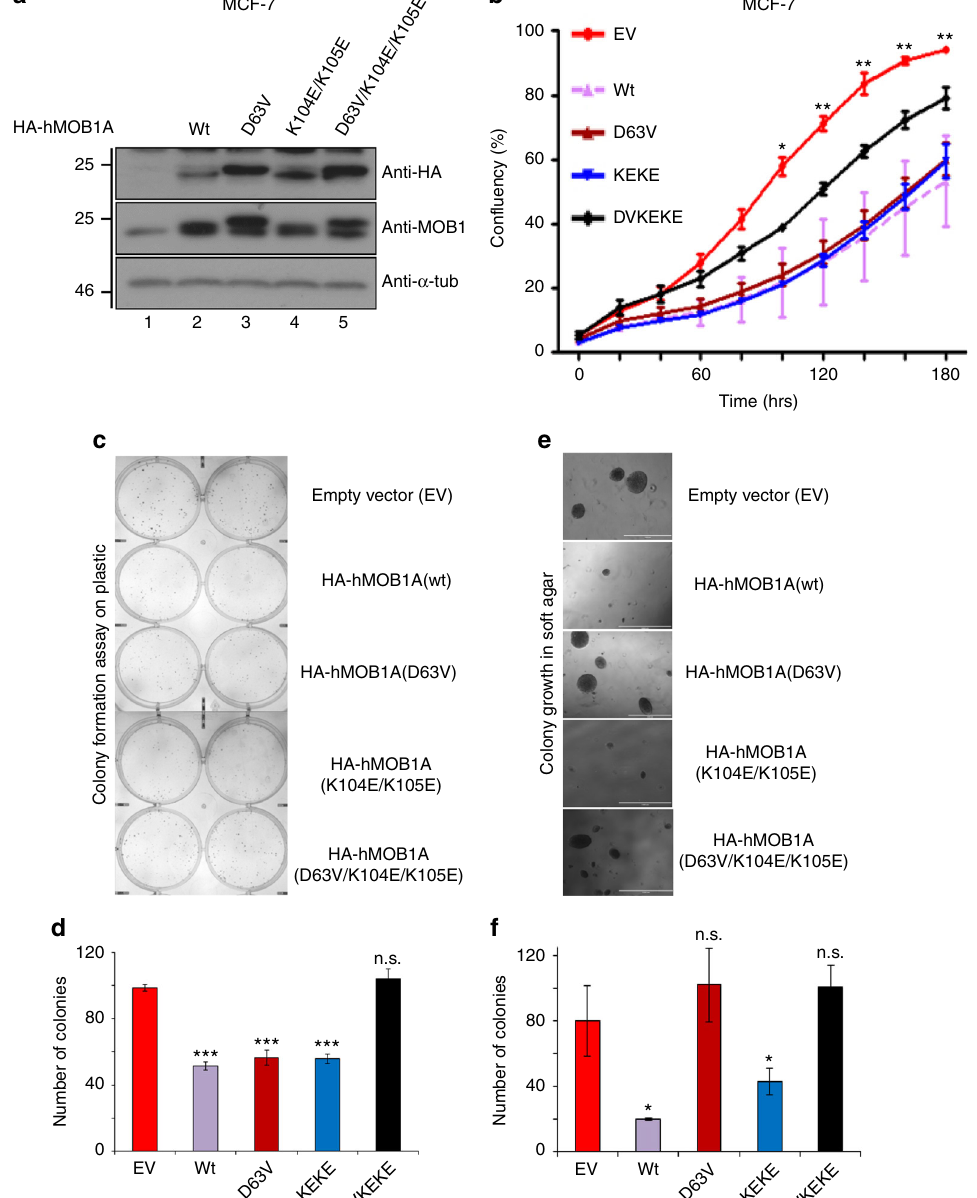
contrast to our 2D observations (Fig. 4b – d), MOB1(wt) or MOB1 (K104E/K105E), but not MOB1(D63V) or MOB1(D63V/K104E/ K105E), signi fi cantly suppressed anchorage-independent growth in 3D (Fig. 4e, f and Supplementary Fig. 14). This suggests that MOB1 interactions with MST1/2 are dispensable, while MOB1